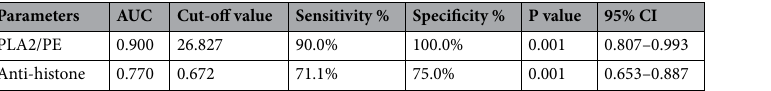
Table 5. ROC-Curve of both variables